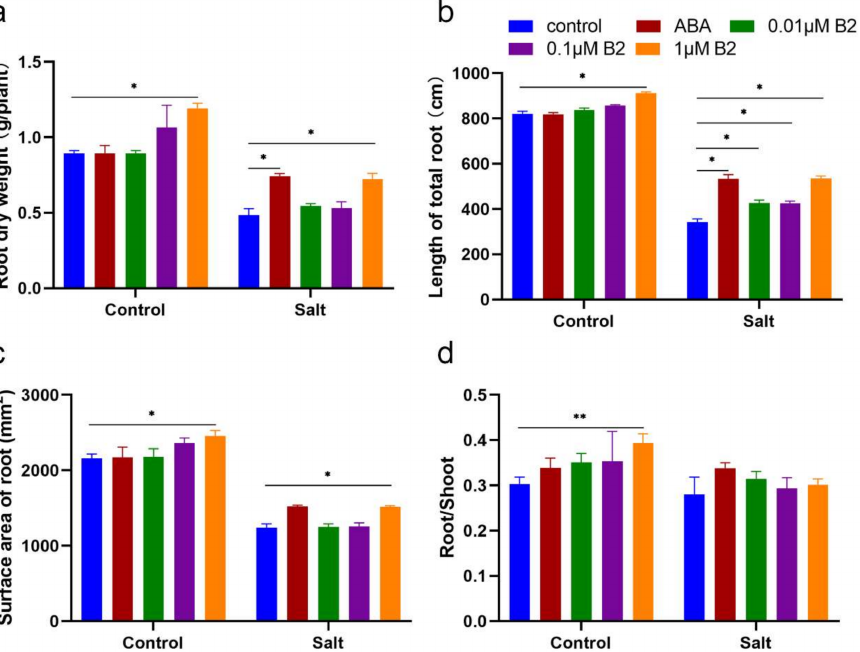
Figure 4. Maize root growth. ( a ) The dry weight of roots. ( b ) The length of total roots. ( c ) The surface area of roots. ( d ) The root/shoot ratio. These measurements were taken 6 days after different treatment. ABA concentration was 100 µ M, B2 concentrations were 0.01 µ M, 0.1 µ M, and 1 µ M. Values were significantly different from controls by t -test at * p < 0.05 or ** p ≤ 0.01. Bars mean SD ( n =